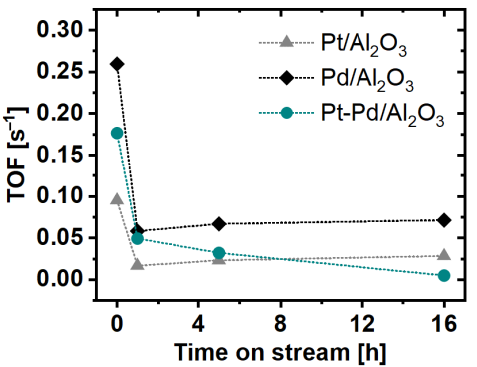
Figure A5. Catalytic activity for NO conversion after reductive and oxidative pretreatment of Pd/Al 2 O 3 (fresh state) during a light-off test in 800 ppm NO, 7% CO 2 , 5% O 2 , 5% H 2 O, and bal. N 2 at a GHSV of 40 000 h − 1 .